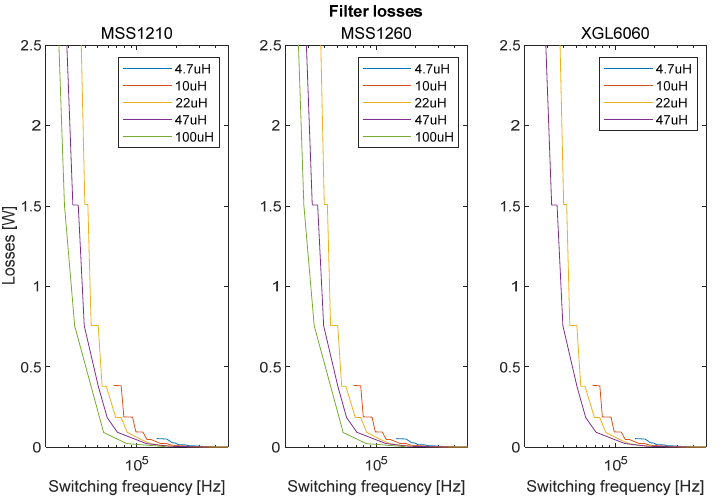
Figure 21. Losses in the output filter depending on the main inductor values (coloured curves) with respect to the switching frequency. The filtering inductor values are the minimum discrete standard values complying with the 60 dBµV limits at LSIN resistors as proposed in Section 4.1.